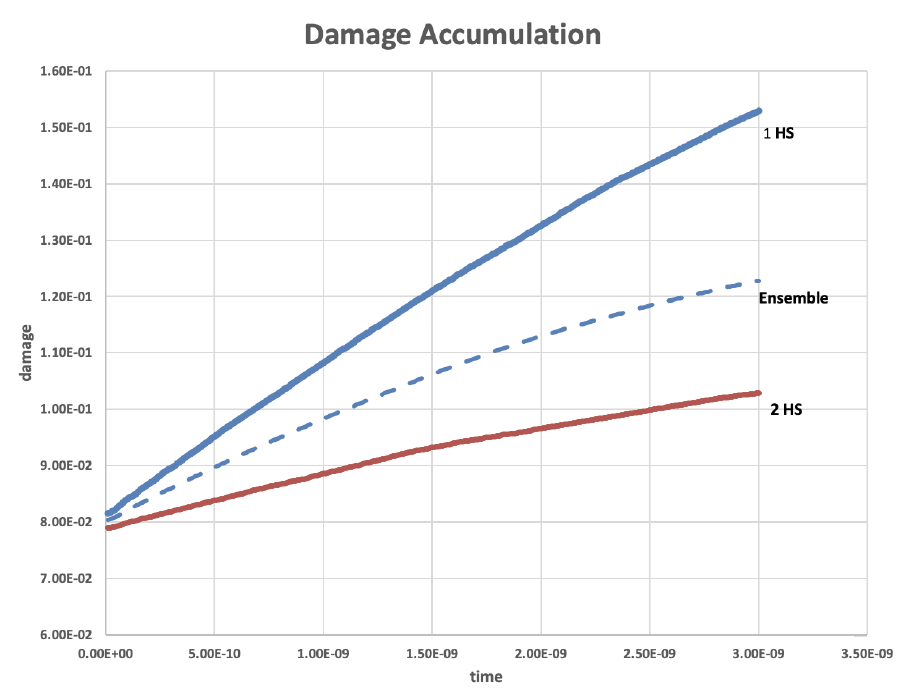
Figure 1. The time rate of accumulated damage is compared for two realizations, one in which one hotspot initially exists and the second in which two hotspots initially exist. The dotted curve represents the average of an ensemble of 100 realizations. All simulations were performed for a strain rate ˙ ϵ = 10 5 s − 1 ; dx = dy = 10 − 6 m. The process zone is 10% of the crack radius. The particular realizations were chosen randomly from the